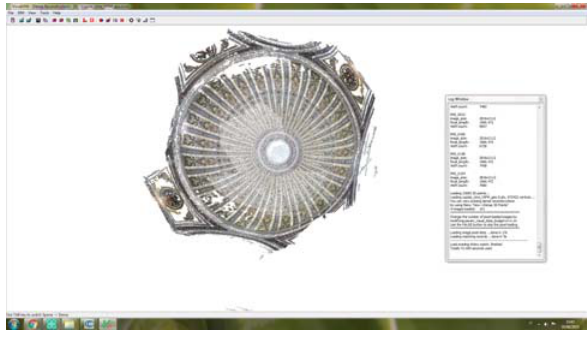
Figure 2: VisualSfM